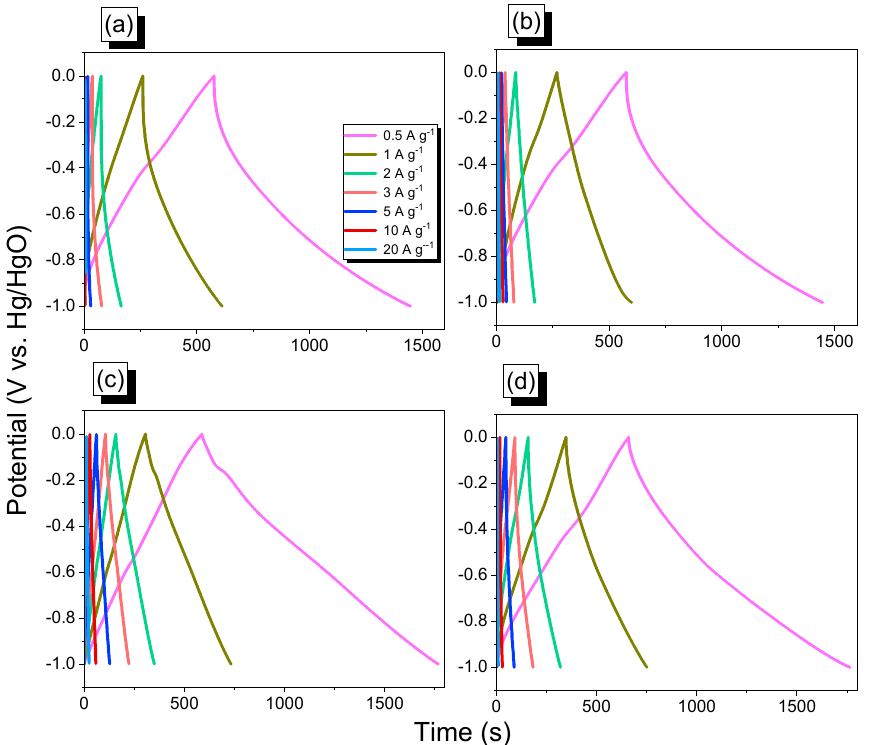
Figure 8. GCD profiles of An-CTF-10-400 ( a ), An-CTF-20-400 ( b ), An-CTF-10-500 ( c ), and An-CTF-20-500 ( d ).